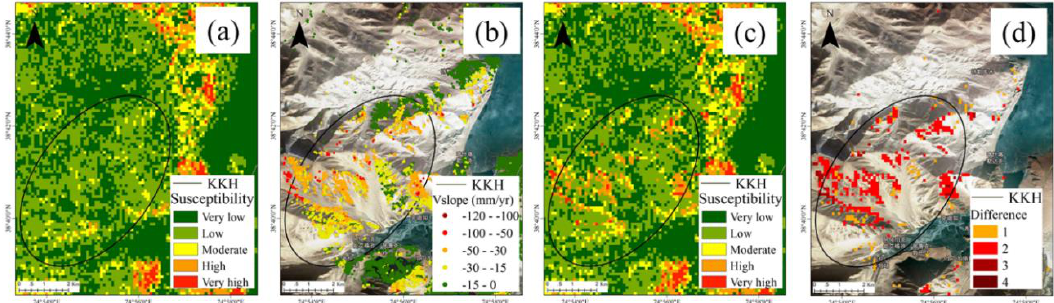
Figure 9. Results of landslide assessment for locality 1 (west of Blumkou Reservoir). ( a ) Landslide susceptibility assessment results obtained using the Random Forest method. ( b ) SBAS deformation rate values along the slope direction. ( c ) Optimized landslide susceptibility assessment results. ( d ) Mapping results of the di ff erence in the degree of landslide susceptibility assessment before and after optimization. Locality 2 is near the Muztag Mountains and glacial moraines are widely distributed.